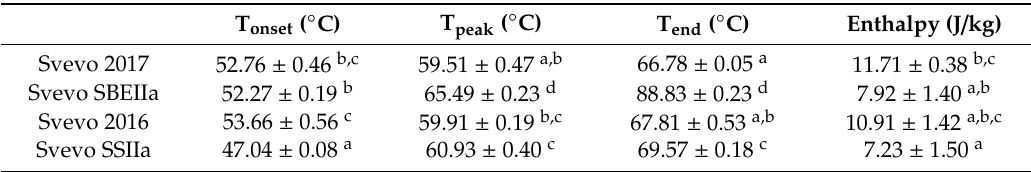
Table 4. Starch gelatinisation properties of